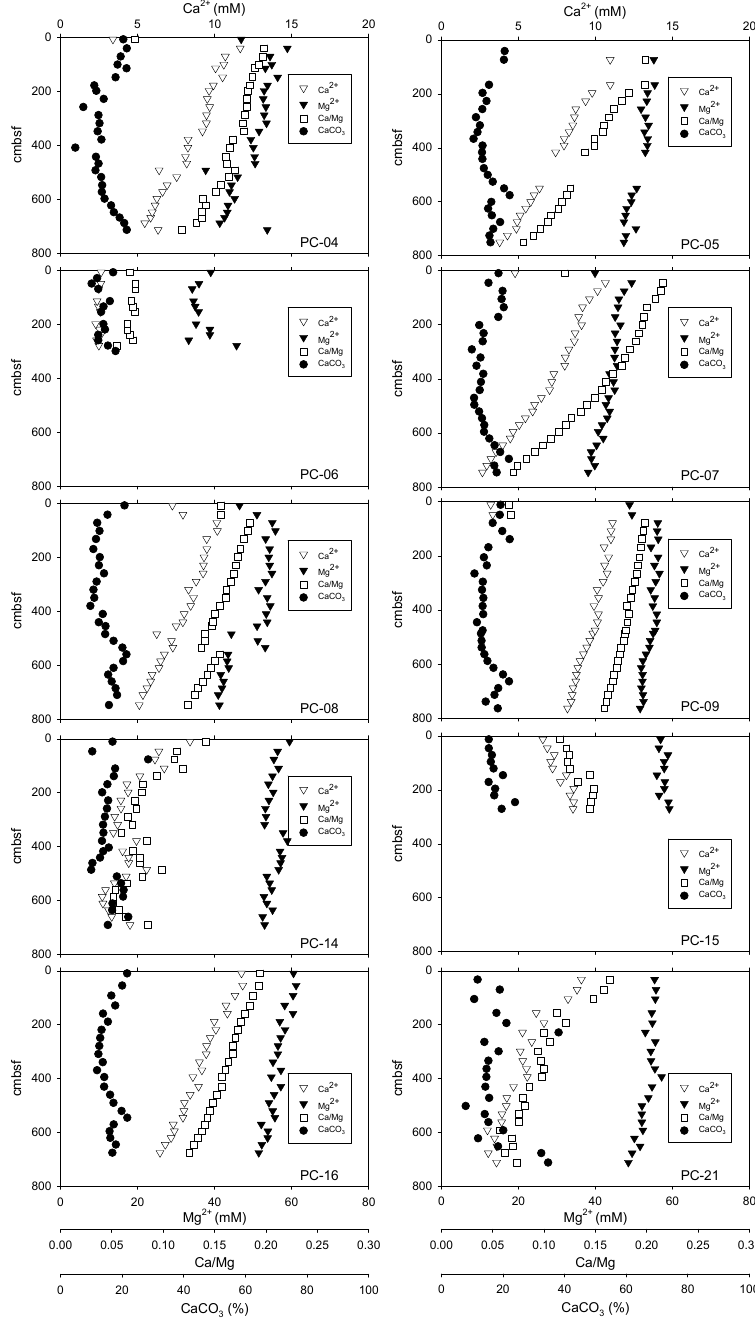
Figure 4. Porewater Ca 2+ and Mg 2+ concentrations, Ca/Mg ratios, and estimated sediment CaCO 3 content vs. depth (CMBSF) for AC-07 piston cores (PC). Core PC-06 contained solid phase hydrates which destabilized during